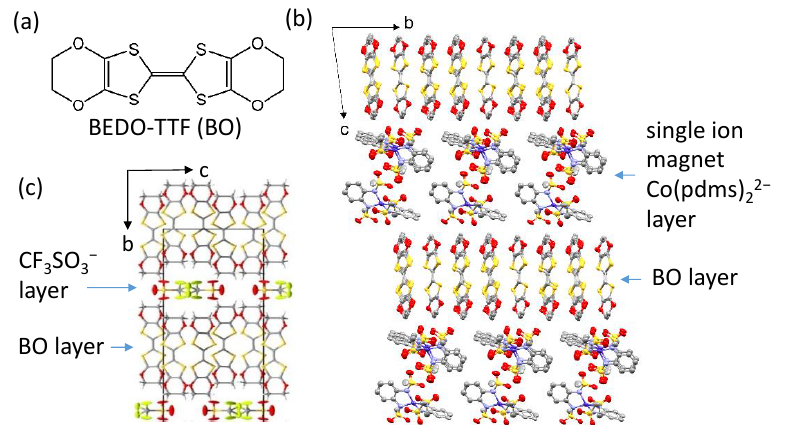
Figure 1. ( a ) The chemical structure of the donor molecule BEDO-TTF or BO , i.e., bis(ethylenedioxy)tetrathiafulvalene). Crystal structures of ( b ) β ” -(BO) 3 [Co(pdms) 2 ](CH 3 CN)(H 2 O) 2 and ( c ) κ -(BO) 2 CF 3 SO 3 viewed along a -axis. Each atom is colored as: gray, C; white, H; blue, N; green, F; navy, Co; red, O; yellow, S.